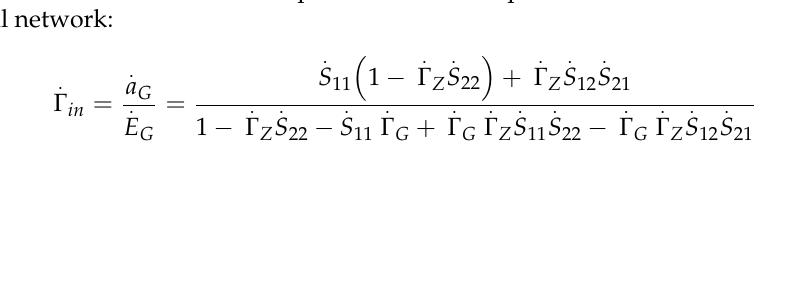
To obtain the magnitude and phase of the input reflection coefficient of the path, it is useful to represent (13) in trigonometric form: